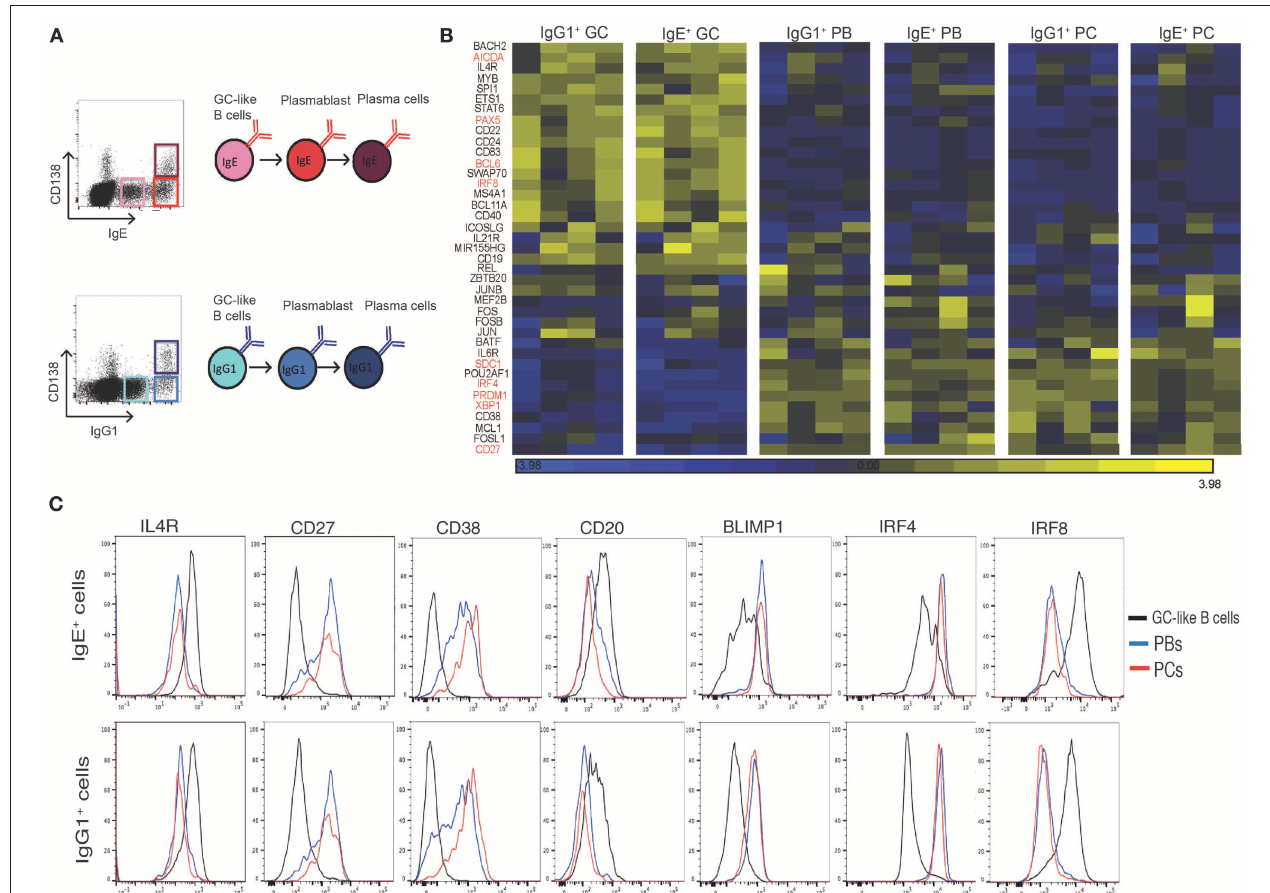
FIGURE 1 | Expression profile of GC and PC associated genes in sorted IgE + and IgG1 + cell populations. (A) IL-4 and anti-CD40 stimulated tonsil B cells were harvested on day 10 of the culture and surface stained for CD138, intracellular IgE and IgG1 and FACS sorted into GC B cells (IgE lo CD138 − and IgG1 lo CD138 − ), PBs (IgE hi CD138 − and IgG1 hi CD138 − ), and PCs (IgE hi CD138 + and IgG1 hi CD138 + ). (B) Heatmap of GC and PC associated genes in each of the sorted IgE + and IgG1 + cell populations. Each column represents the gene expression profiles of the different phenotypic cell populations sorted from four different tonsil B cell cultures. (C) Flow cytometric validation of seven differentially expressed genes in IgE + and IgG1 + cell populations. Data are representative of 6 experiments.